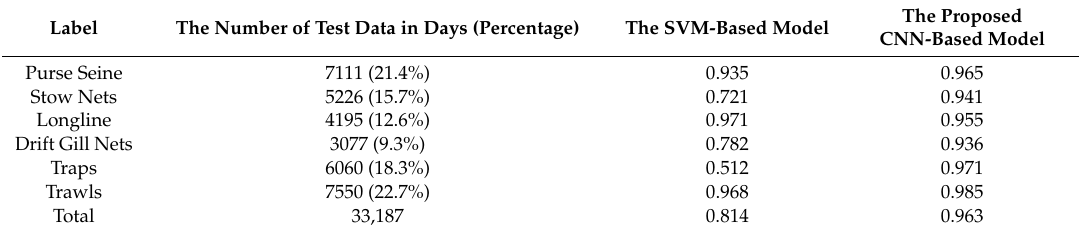
Table 6. Day-wise performance index (DPI) scores for the SVM-based and the CNN-based